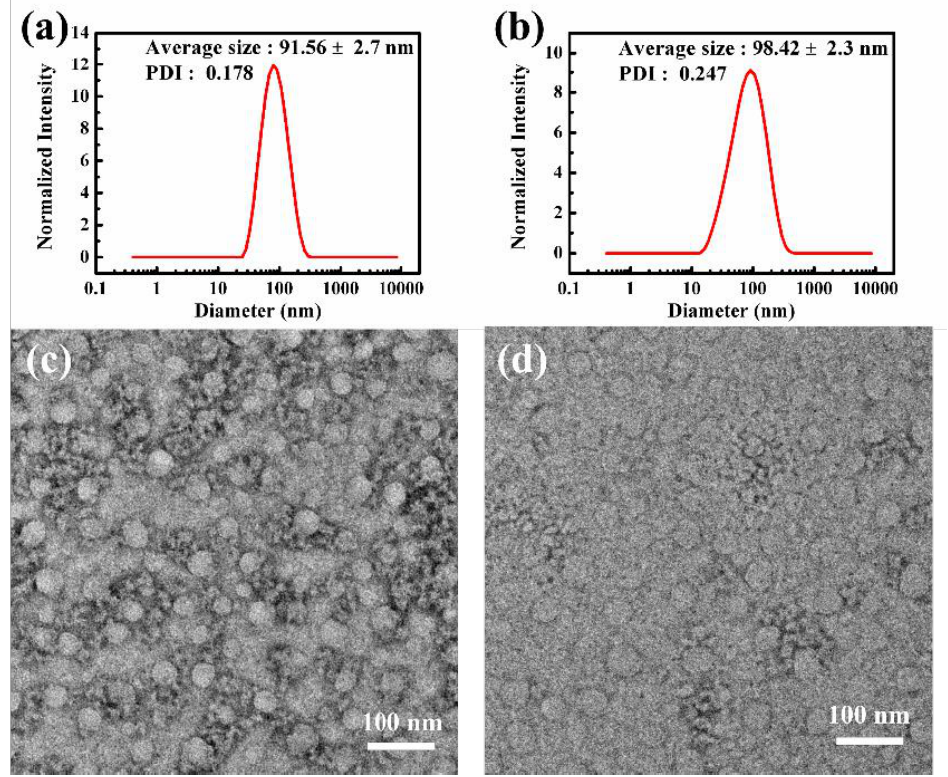
Figure 6. Size distributions of DOX@P 2 -1 ( a ), and DOX@P 2 -2 ( b ) micelles in water; TEM images of DOX@P 2 -1 ( c ), and DOX@P 2 -2 ( d ) micelles in water at a polymer concentration of 0.5 mg/mL (scale